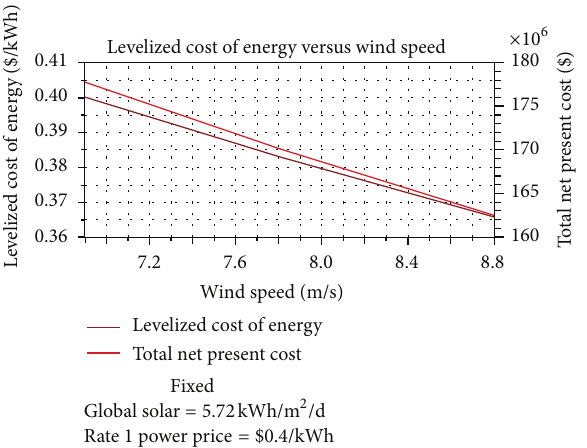
Figure 15: The relationship between cost and wind speed.